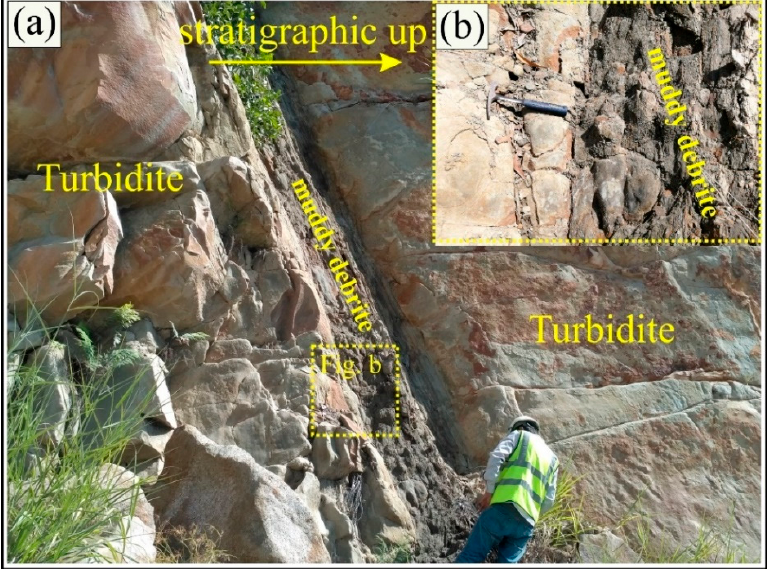
Figure 2. ( a ) Deep-marine sediments contain various types of deposits as we move stratigraphically from base to top of an exposed section in the Benoni Quarry (BQ), SW Sabah. It is possible to find muddy debrite in between two turbidite sandstone units. ( b ) An enlarged image of the contact of turbidites and debrite with lack of transformation of flow and, consequently, no expression of hybrid event intervals in this stratigraphic